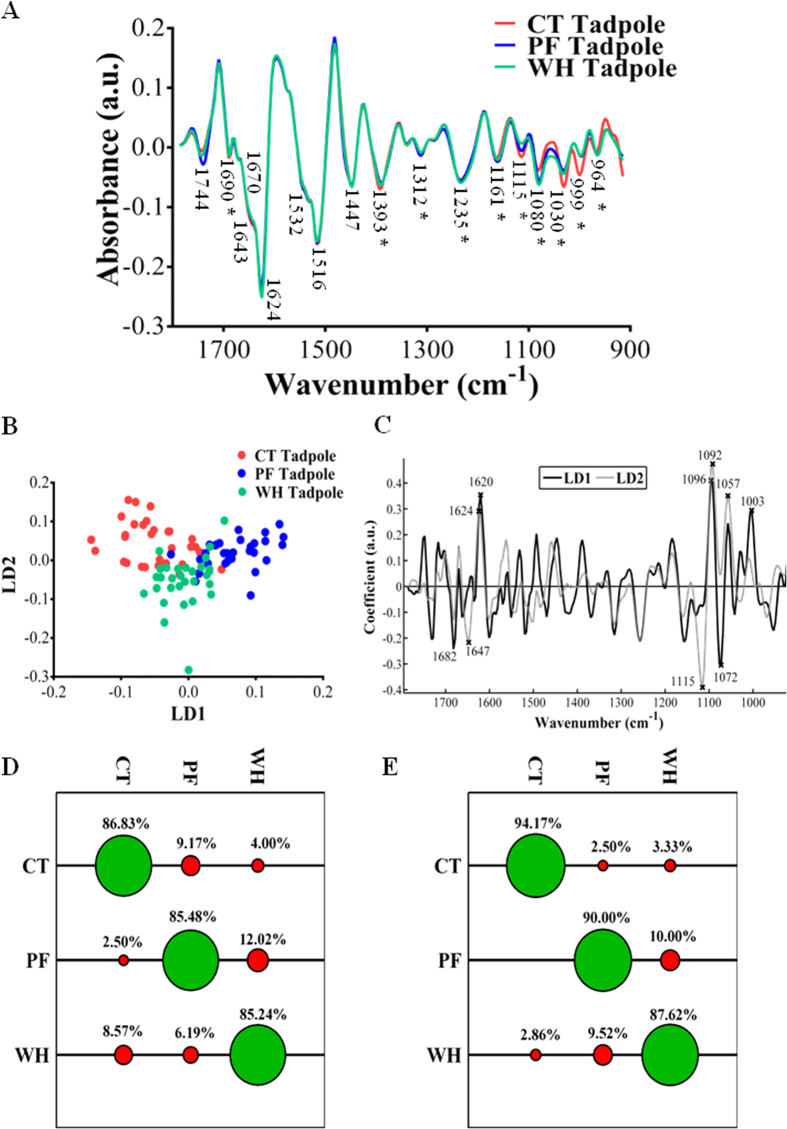
(A) Second derivative mean spectra of Rana temporaria tadpoles collected from ponds with differing water quality over a three year period (2012–2014) from CT: a rural agricultural pond with minimal pesticide input; PF: an urban pond impacted by wastewater and landfill run-off and WH: an agricultural pond known to be impacted by pesticides. Spectra were cut at the biochemical fingerprint region (1800–900 cm−1), processed with Savitzky-Golay second-order differentiation and vector-normalised. Asterisks denote significant differences (P < 0.05) at absorbance peaks following one-way ANOVA. (B) Two-dimensional scores plot generated following cross-validated PCA-LDA analysis of spectra. (C) Corresponding loadings generated from PCA-LDA analysis; the eight largest loadings values are highlighted. (D) Tadpoles classified by PCA-LDC. (E) Tadpoles classified by SVM. Green circles show % correct classification rate, red circles show % incorrect classification rate.